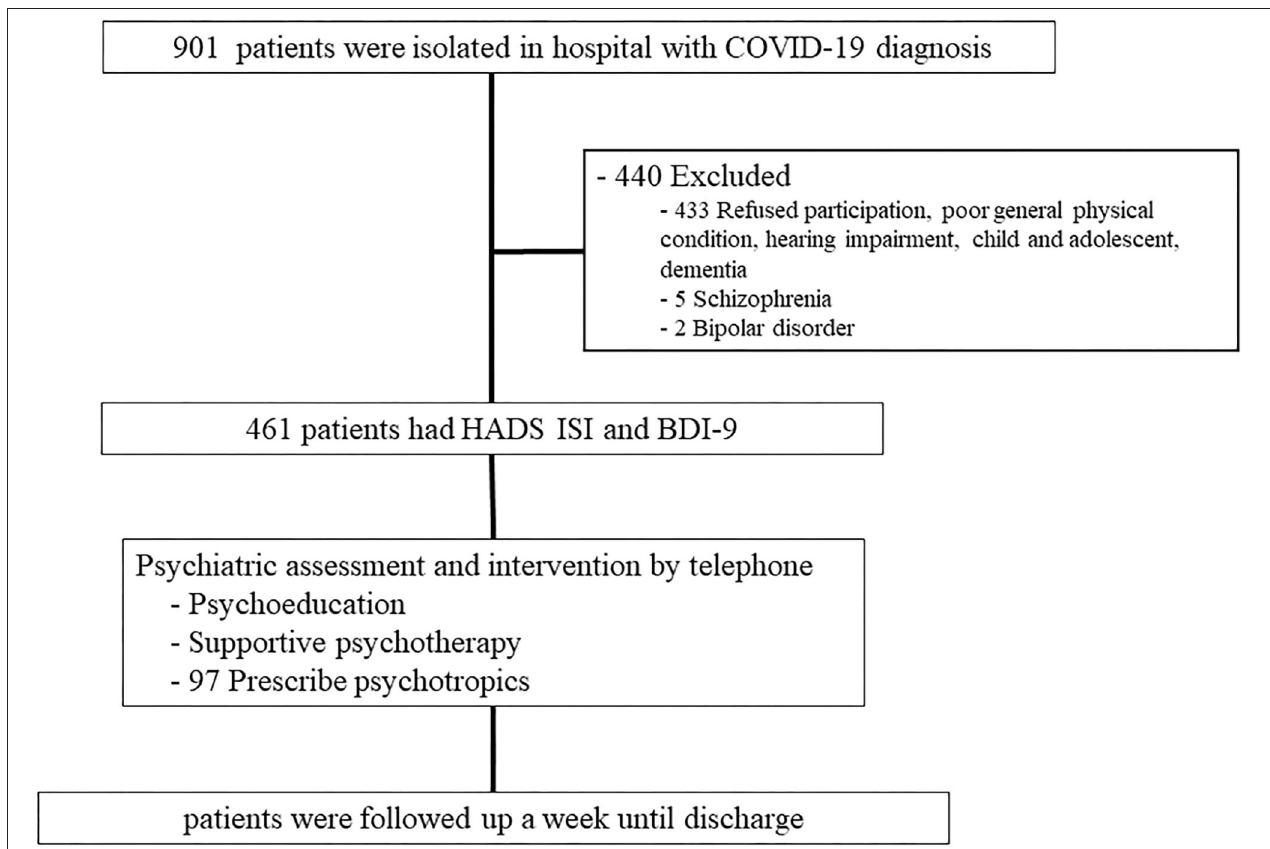
FIGURE 1 | Flow chart of the study. HADS-A, Hospital Anxiety and Depression Scale- Anxiety; HADS-D, Hospital Anxiety and Depression Scale- Depression, ISI, Insomnia Severity Index; BDI, Beck Depression